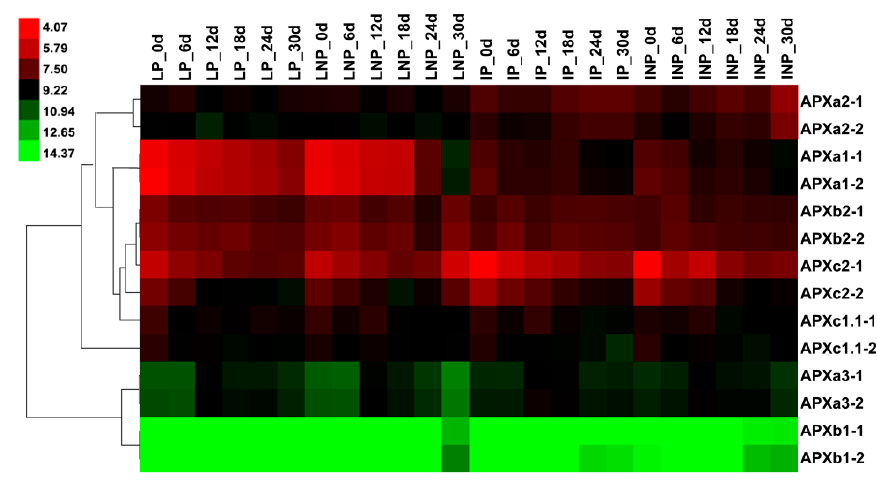
Figure 7. Expression patterns of APX genes in maize leaves and internodes under induced senescence. The experimental data were downloaded from ZM54 in PLEXdb [32]. Colors represent the expression levels for each gene, which are either above (red), below (green), or at the mean expression level (black). Developmental stages are mentioned on top, while the genes are mentioned on the right.